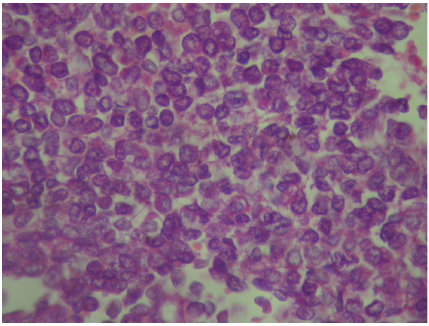
Figure 3: Small-sized round cells with scanty cytoplasm were seen in light microscopic evaluation ( ×